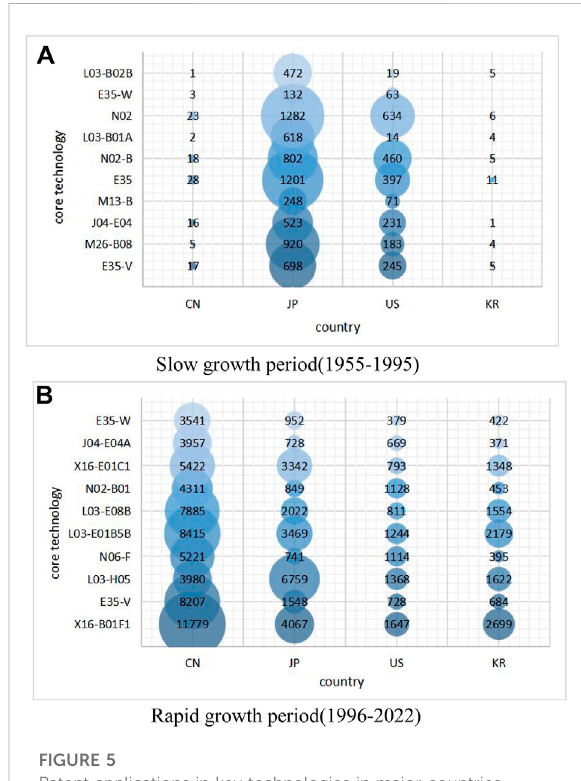
FIGURE 5 Patent applications in key technologies in major